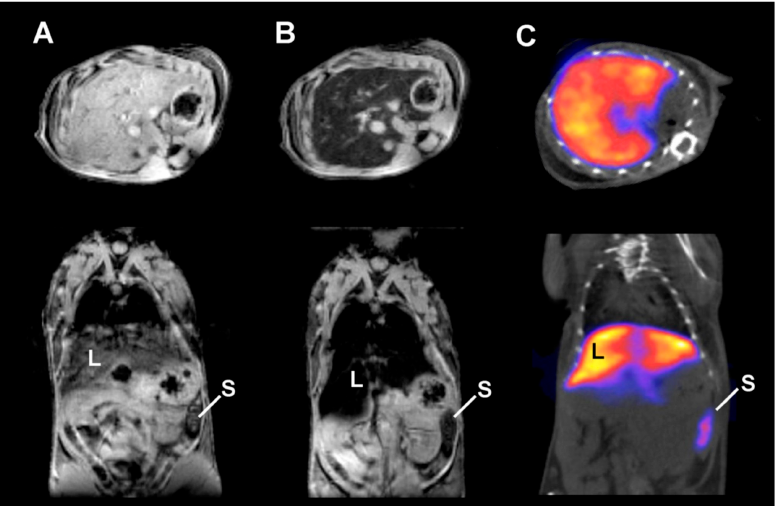
Figure 2. Representative ( A , B ) T 2 *-weighted axial ( top ) and coronal ( bottom ) MRI data of 99m Tc-DPA-ale-Endorem: ( A ) before injection; ( B ) 15 min post-injection (p.i.); ( C ) Representative SPECT-CT image of the same mice 45 min p.i. (L: liver, S: spleen). (Reprinted with permission from [34]. Copyright 2011 American Chemical